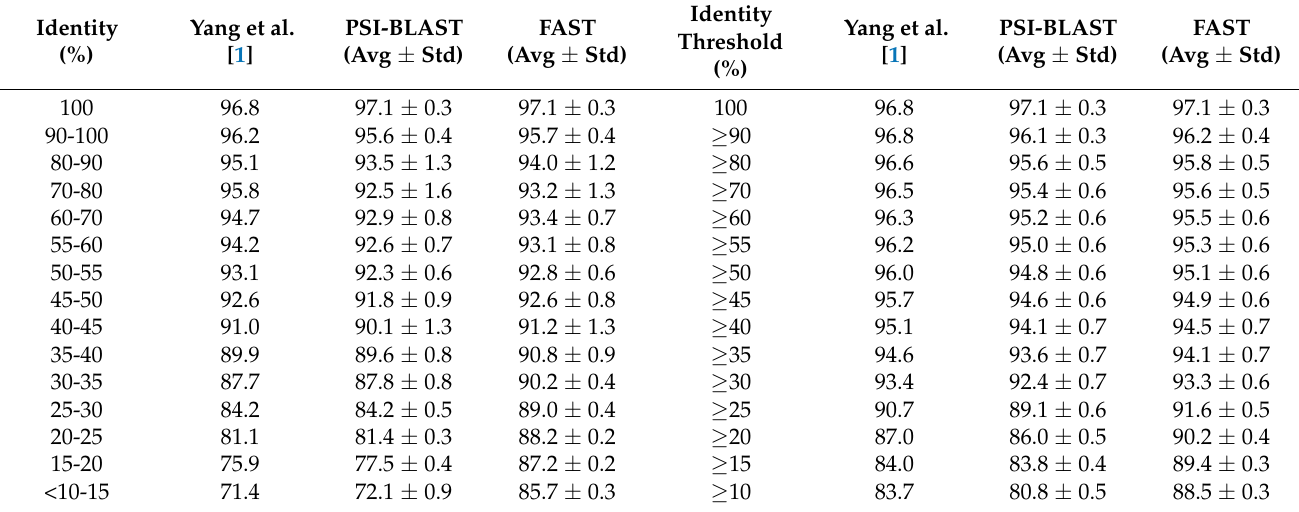
Figure 1. Secondary structural consistency between homologs identified by PSI-BLAST from PDB. ( a ) Secondary structural consistency at different sequence identity levels. The horizontal axis indicates the sequence identity level where, for instance, 30 means that the sequence identities of homologous structures fall between ≥ 30% and <35%. These levels were made according to Yang et al. [1]. The consistency dropped as the identity decreased, and our 10-repeat experimental results agreed well with [1] (the solid purple curve of Q3 versus the red). Yang et al. only analyzed high resolutions (<3 Å) X-ray structures. Following the same filtering criteria, our results (dotted purple curves) were closer to theirs. For easy observation, we enlarged the vertical axis of Q3 with identities ≥ 50. The secondary structural consistency revealed the structural difference between homologs, which is the ultimate factor limiting SSP accuracy. For instance, at the 30% identity level, the averaged consistency is 87.8%, meaning an 11.2% difference in secondary structure, which indicates that the SSP accuracy of such homologs can be at most ~88%. Previous studies measured the secondary structure consistency by sequence alignments [1,62]. We also performed structural alignments (black lines). ( b ) Secondary structural consistency at different sequence identity thresholds. The horizontal axis indicates the threshold where, for instance, 30 means that the sequence identities of homologous structures are ≥ 30%. Previous studies estimated the limit of SSP on the basis of three-state SSEs. We also made estimations based on the eight-state SSEs. Table 2. Three-state secondary structural consistency measured by sequence/structure alignments for homologs identified from